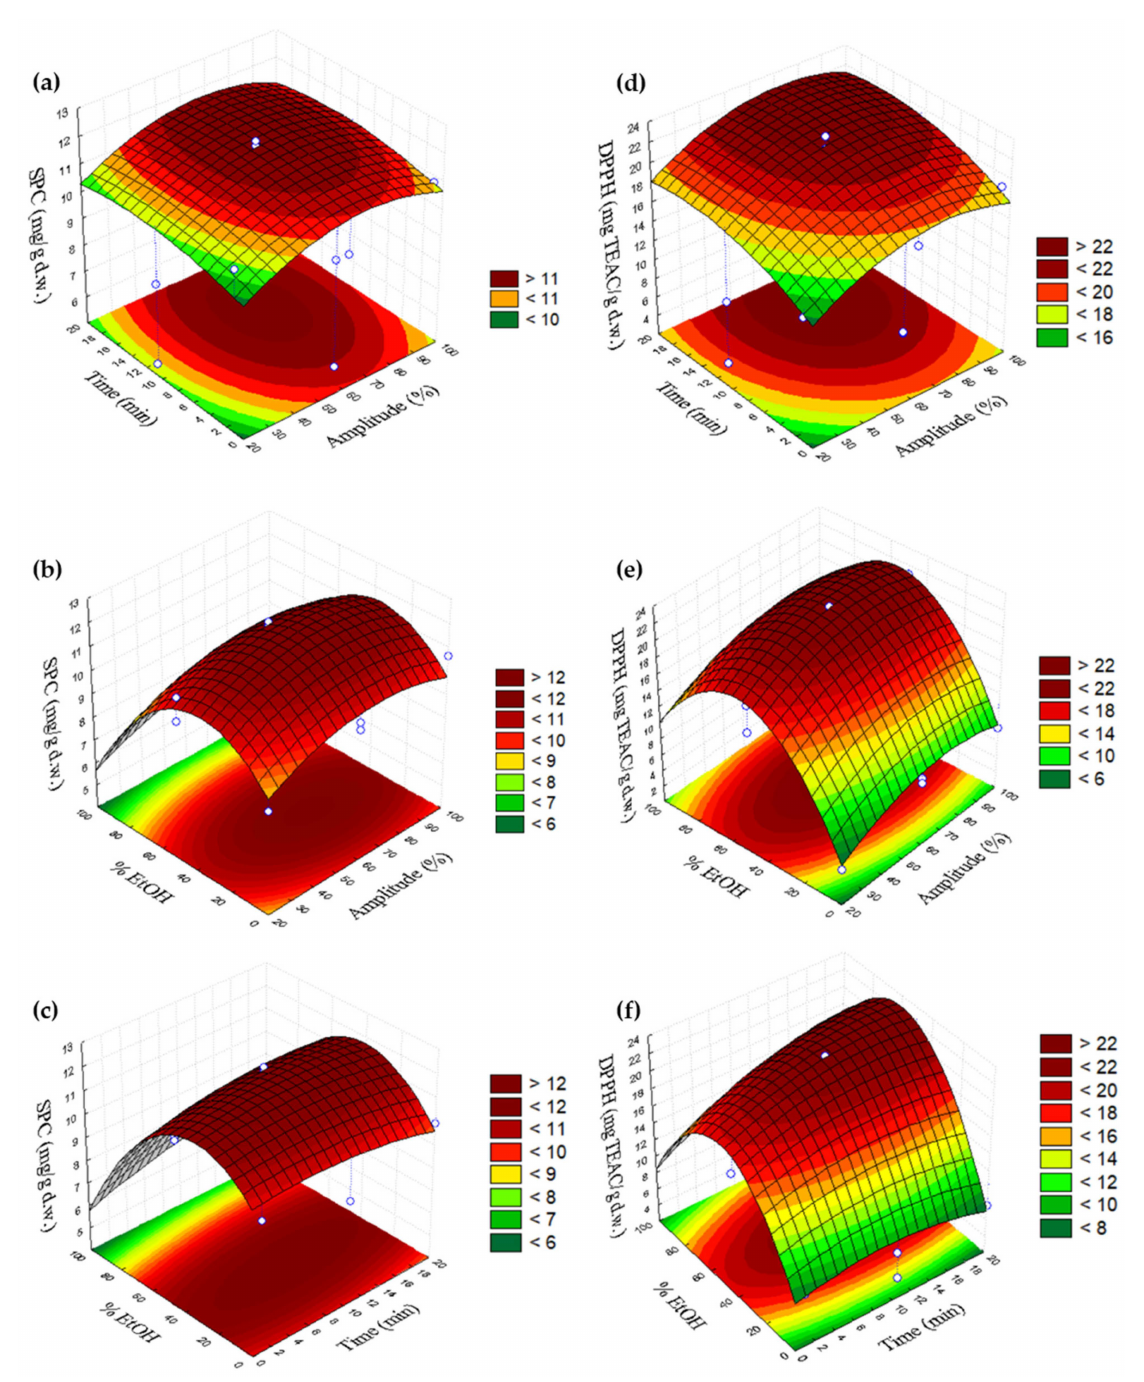
Figure 1. Three-dimensional plots showing the effects of % amplitude ( v / v ) (X 1 ) with time (X 2 ) ( a , d ), % amplitude (X 1 ) with % EtOH (X 3 ) ( b , e ) and time (X 2 ) with % EtOH (X 3 ) ( c , f ) on the sum of phenolic compounds and